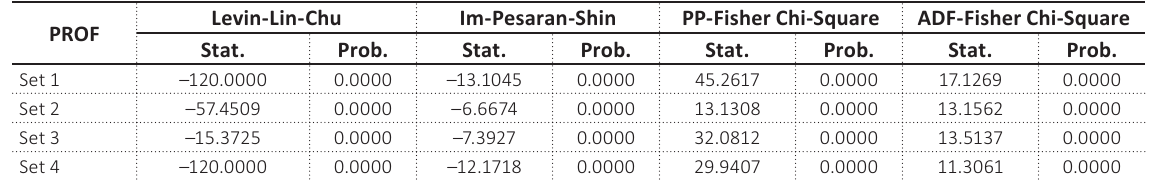
Table 4. Result of panel unit root test